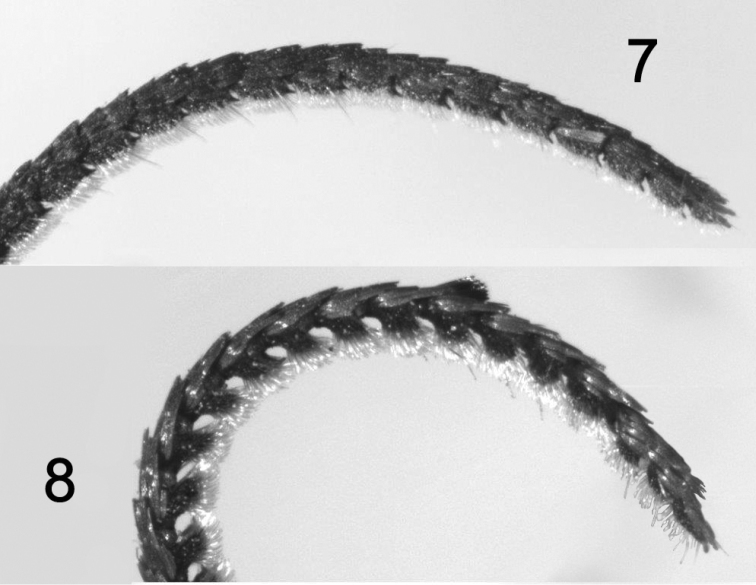
Lateral view of male antennae: 7Hypoprepiainculta8Hypoprepialampyroides